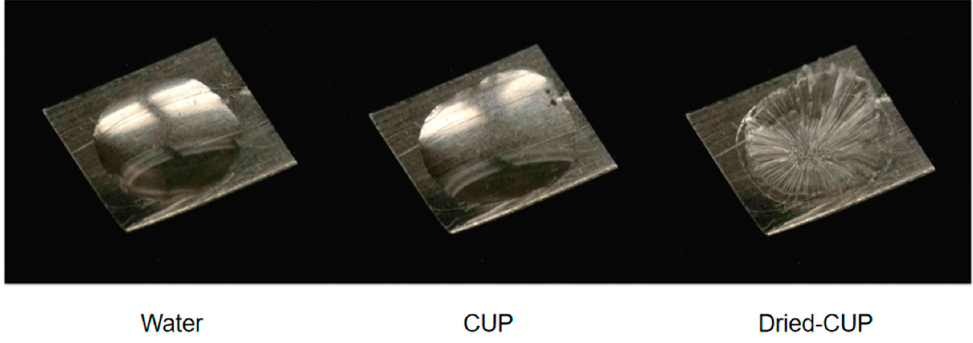
Figure 3. Photo of deionized water and CUP wetting and dry on platinum substrate.